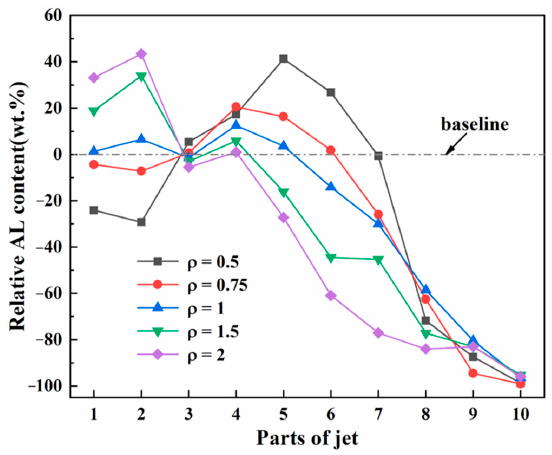
Figure 19. Relative Al content in each part of jet.